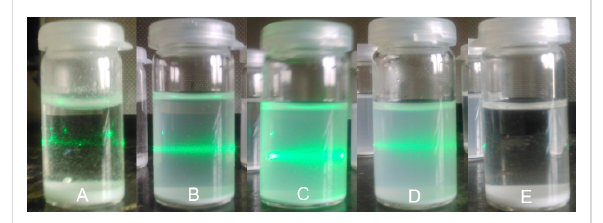
Figure 4: CaPhP nanoparticles in various solvents 24 hours after ultra- sound treatment (A – distilled water, B – propan-2-ol, C – ethanol, D – butanol, E – acetone). The green line is Tyndall scattering by a green laser.